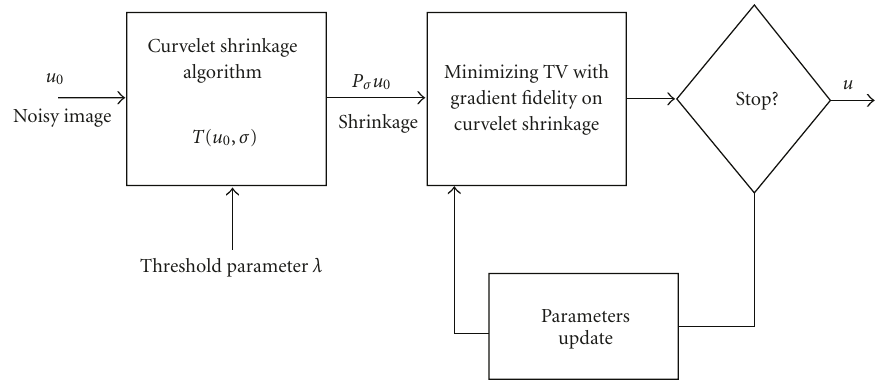
Figure 2: Illustrate the proposed self-optimizing image denoising